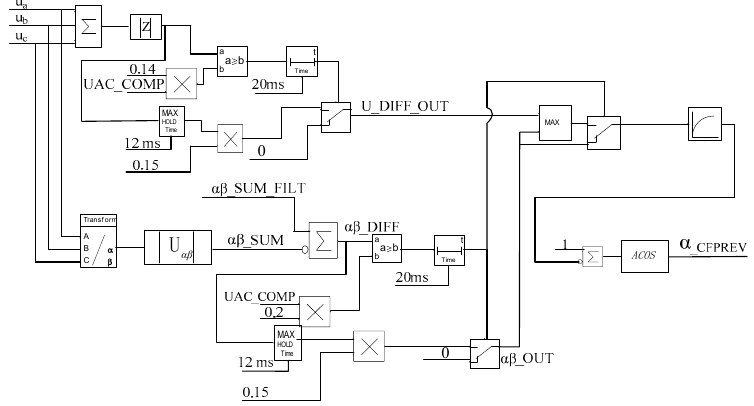
Figure 2. A simplified logic diagram of commutation failure prediction (CFPREV).